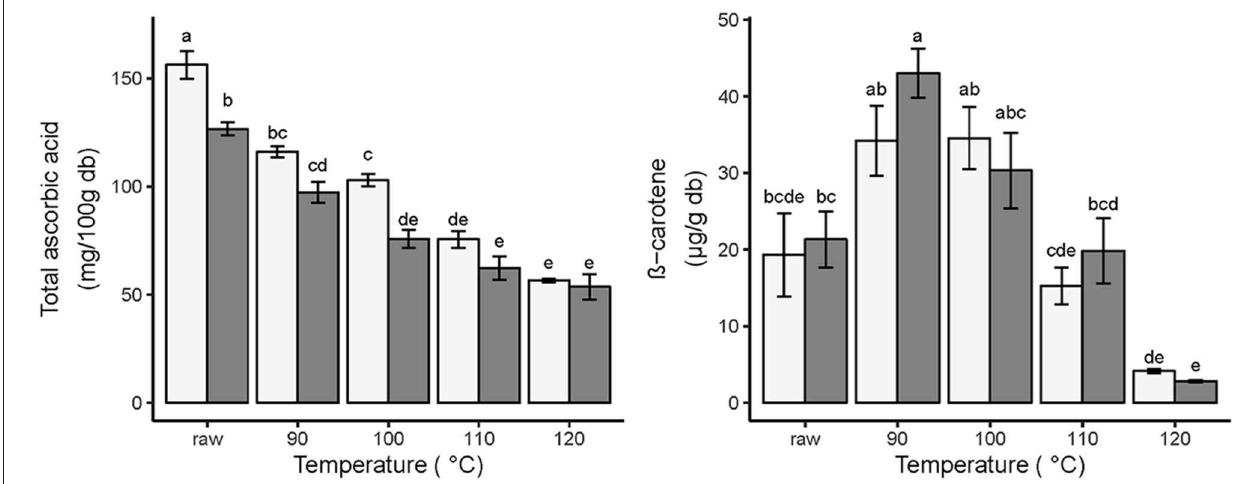
FIGURE 2 | Effects of vacuum frying and ripening stages of mango on total ascorbic acid (mg/100g db) (left) and β -carotene ( µ g/g db) (right) during vacuum frying. Light bars represent unripe mango; dark bars represent ripe mango. The different frying temperatures also represent the different final frying times; 90 ◦ C (50min); 100 ◦ C (35min); 110 ◦ C (25min); 120 ◦ C (15min). Error bars are standard error. Different letters above the error bars show significant difference between treatments N =